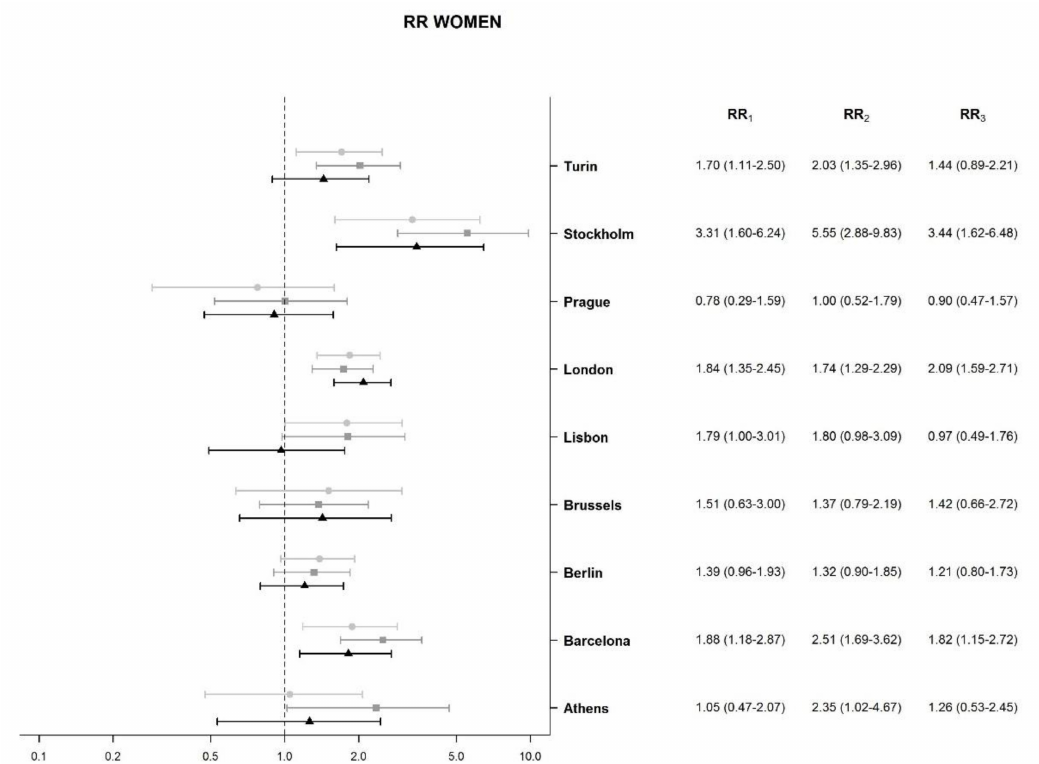
Figure 2. Association between socioeconomic deprivation index and liver cirrhosis mortality, relative risk (RR), and 95% credible intervals (CI) for women in nine urban areas. Notes: RR compares liver cirrhosis mortality of the 95th percentile value of socioeconomic deprivation (severe deprivation) to the 5th percentile value (low deprivation). RR 1 : RR in the first period (2000–2003); RR 2 : RR in the second period (2004–2008); RR 3 : RR in the third period